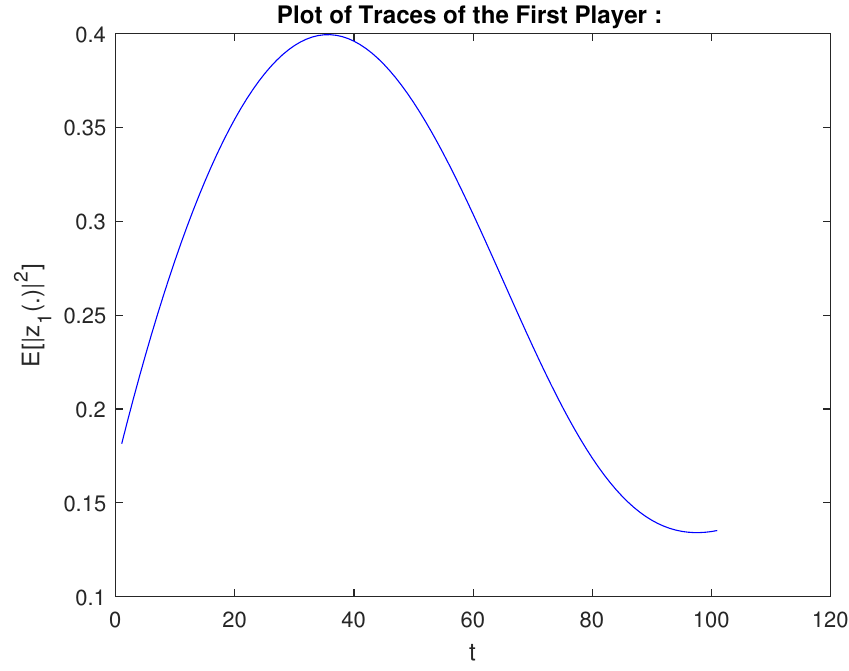
Figure 1. Plot of traces of the first player: E [ | ˜ z 1 ( jh ) | 2 ] in [ 0, t f ] = [ 0,1 ] . Plot of Traces of the Second Player :